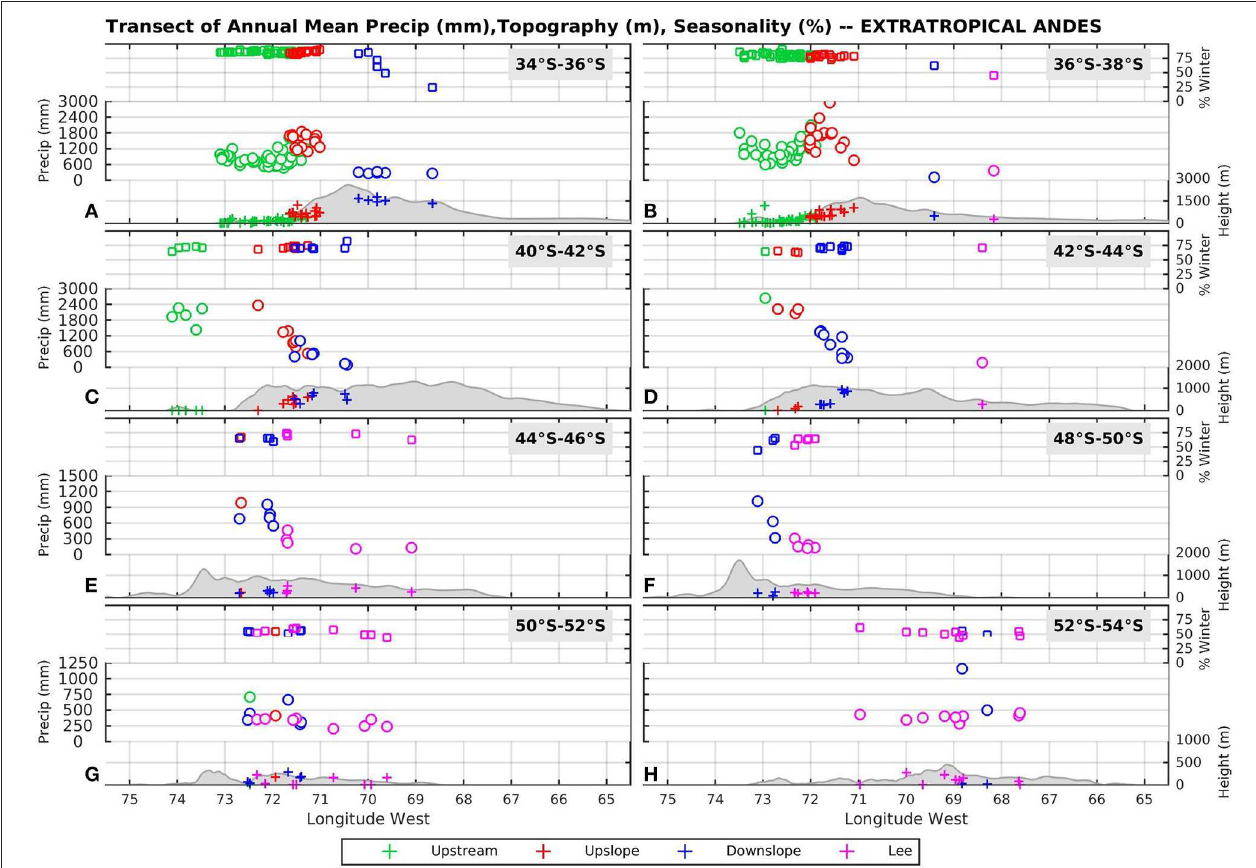
FIGURE 4 | Same as Figure 3 but for the extratropical Andes. Again, each transect is plotted within a 2 ◦ width latitudinal band according to the data availability: (A) 34 – 36 ◦ S, (B) 36 – 38 ◦ S, (C) 40 – 42 ◦ S, (D) 42 – 44 ◦ S, (E) 44 – 46 ◦ S, (F) 48 – 50 ◦ S, (G) 50 – 52 ◦ S, and (H) 52 – 54 ◦